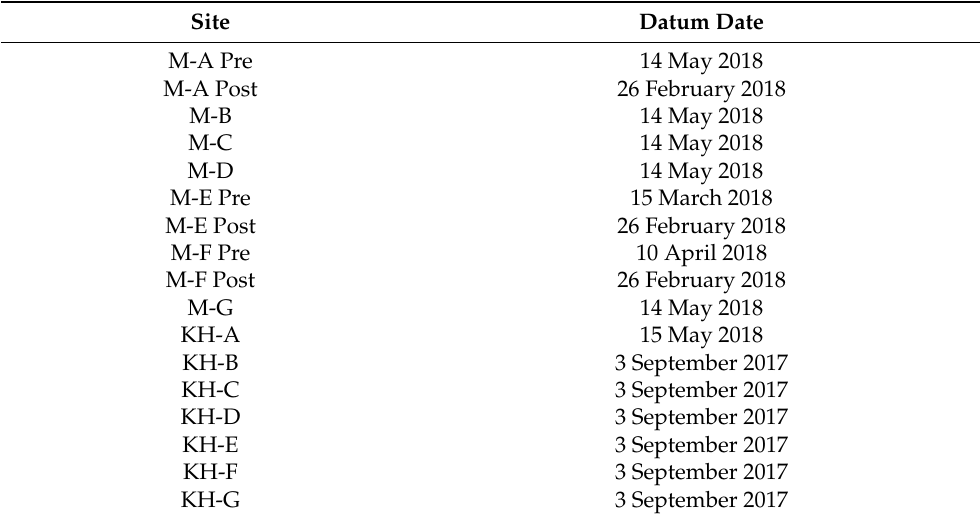
Table 1. Ground Datums used for comparison of InSAR and Ground measurements at each subsite (APSIS InSAR dates ± 3 days of